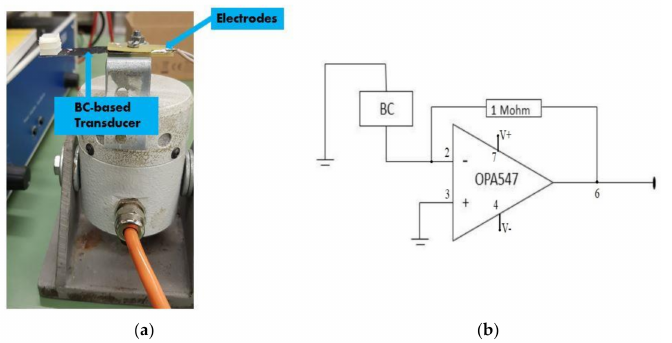
Figure 3. ( a ) Zoom of the BC-based transducer mounted on the shaker. In the figure, the rigid electrical contacts can be seen; ( b ) electrical scheme of the conditioning circuitry used for the current to voltage conversion, in SC working conditions.